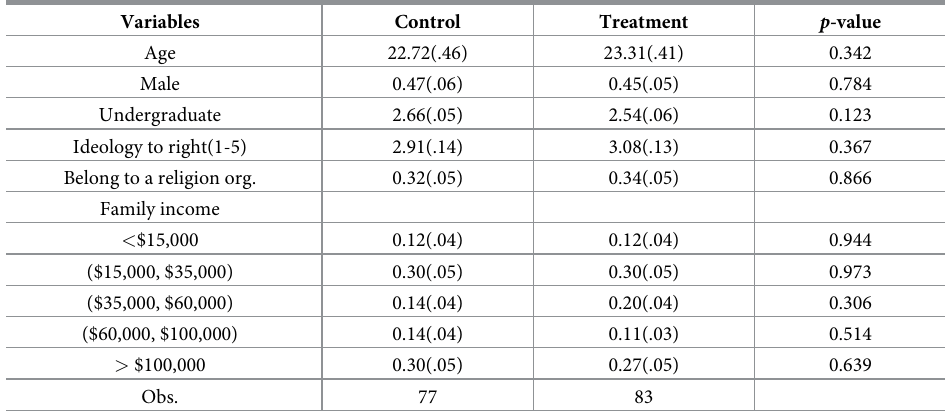
Table 1. Balance